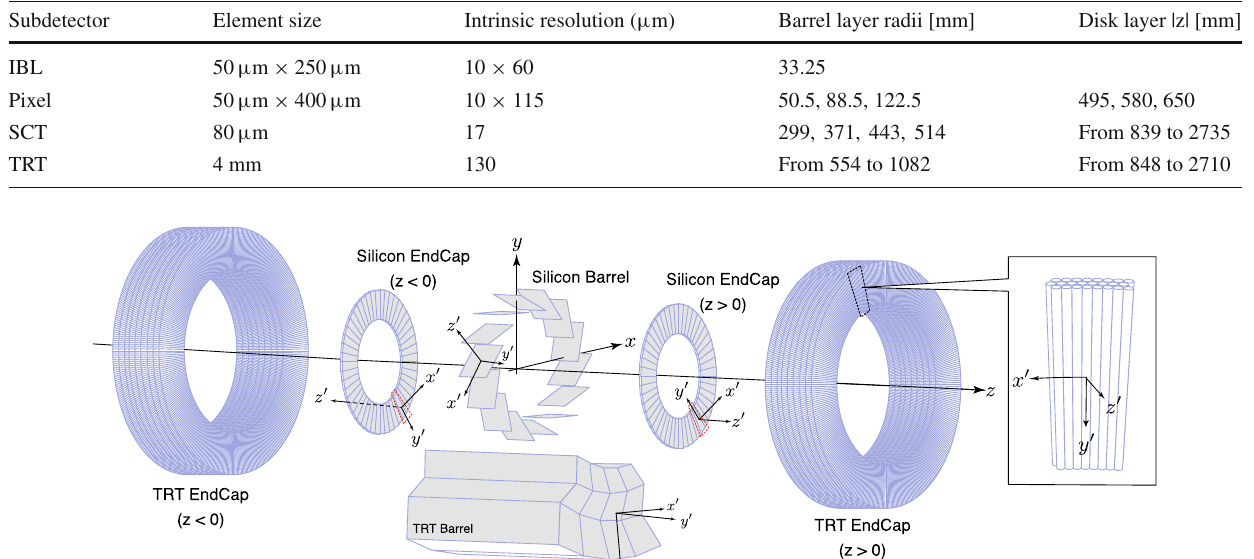
Table 1 Summary of the main characteristics of the ID subdetectors. The intrinsic resolution of the IBL and the Pixel sensors are reported along r – φ and z , while for SCT and TRT only the resolution along r – φ